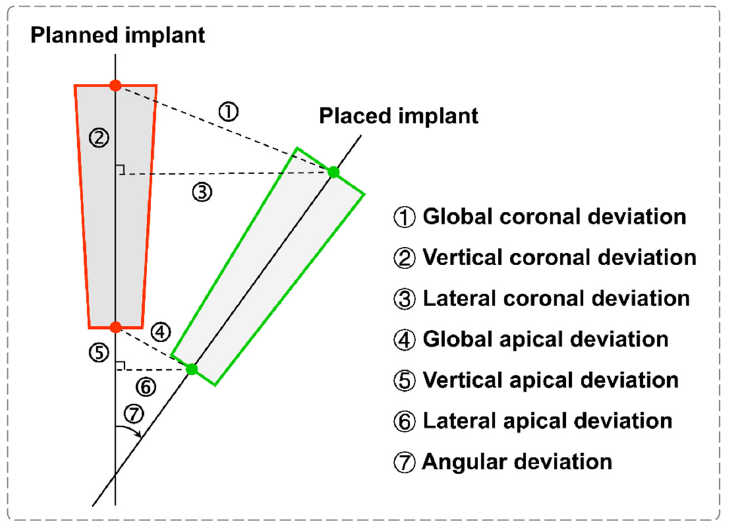
Figure 7. Schematic image of accuracy parameters between the planned and placed implants.